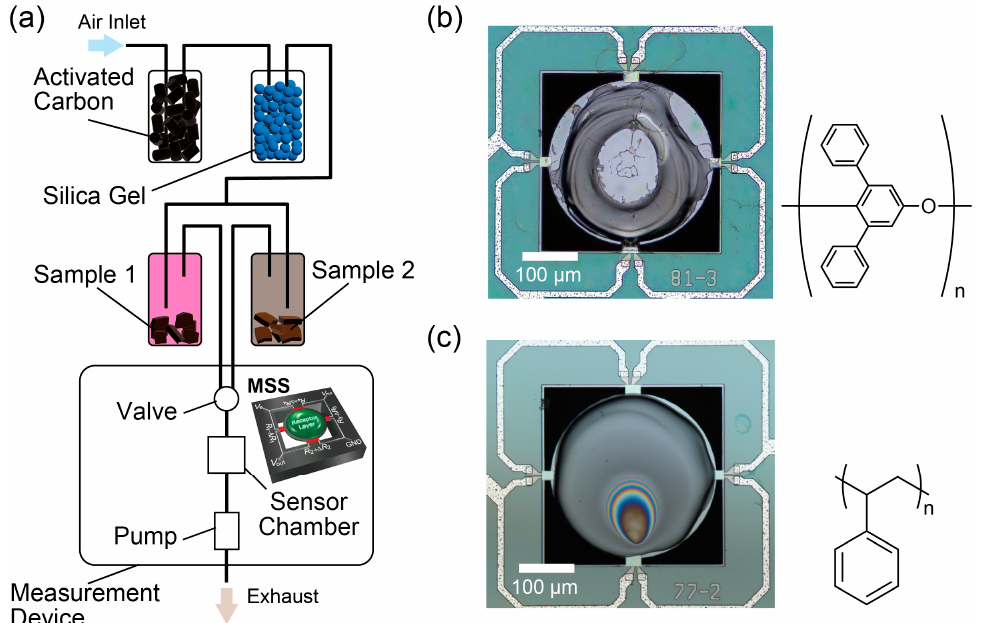
Figure 2. ( a ) A schematic illustration of the measurement setup for the rDC method. In this study, MSS was used as a gas sensor. ( b , c ) Optical microscope images of MSS coated with ( b ) PPPO and ( c ) PS. The molecular structures of PPPO and PS are shown on the right of the microscope images.